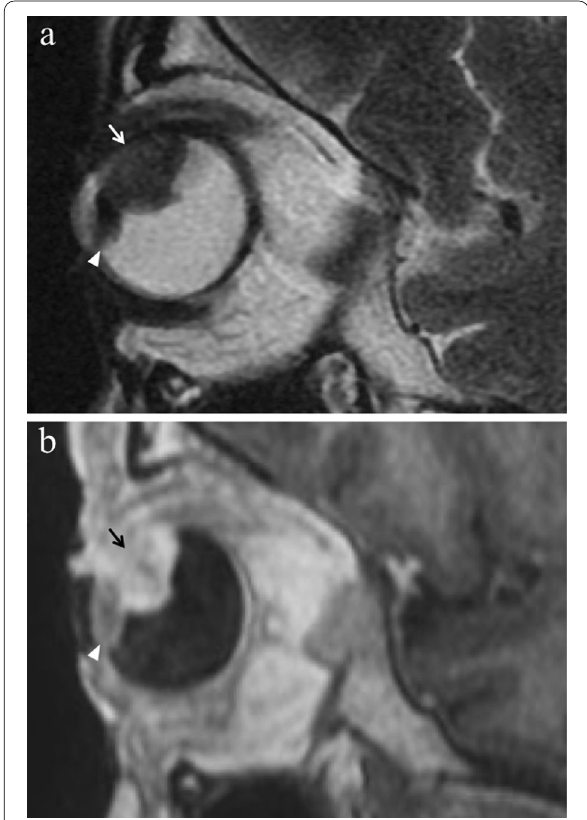
Fig. 1 A 40-year-old male welder with a ciliary body melanoma of the left eye determining lens displacement. Sagittal ( a ) T2-weighted turbo spin-echo STIR and ( b ) contrast-enhanced 3D T1-weighted images show a mass (arrows) along the antero-superior aspect of the globe, displacing the lens (white arrowheads). The lesion is hypointense on T2-weighted image (white arrow) and demonstrates enhancement on post-contrast T1-weighted image (black